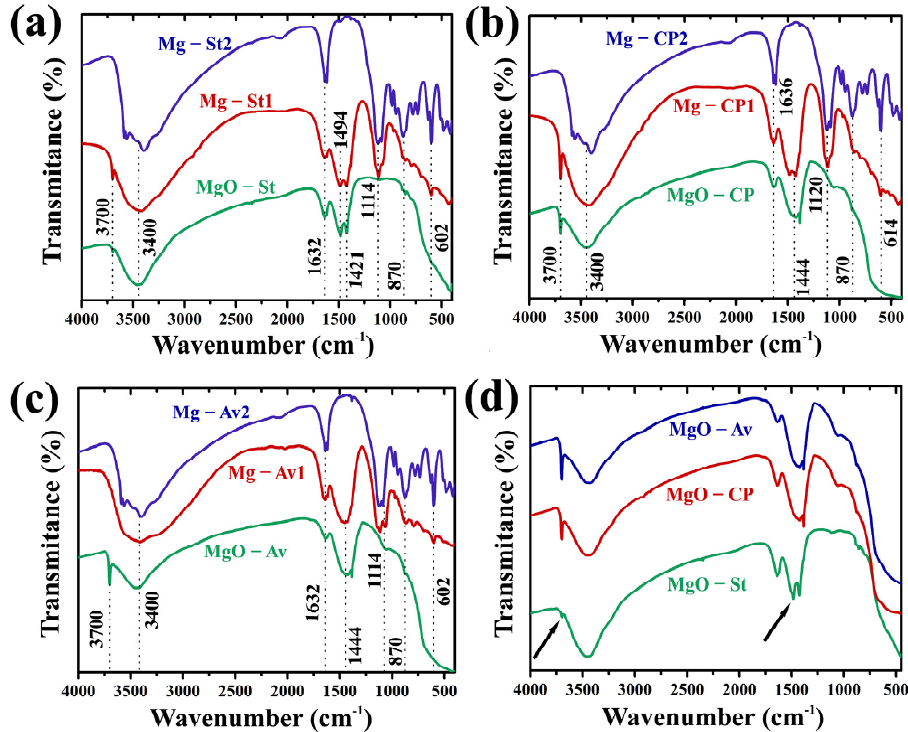
Figure 7. FTIR spectra of MgO before and after Cu 2+ adsorption for MgO − St ( a ), MgO − CP ( b ), and MgO − Av ( c ) with an increased Cu 2+ concentration, and comparison between the three synthesized oxides ( d ).